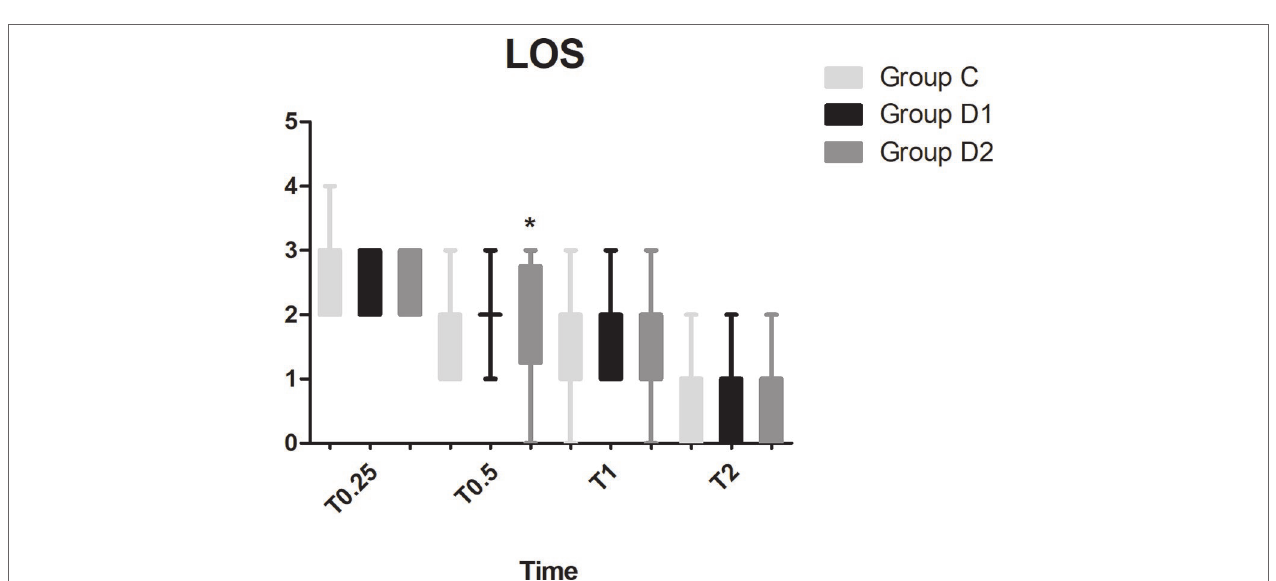
FIGURE 6 | Comparison of patient sedation among the three groups using the level of sedation (LOS). LOS: 1, the subject is anxious, agitated, or restless; 2, the subject is cooperative, oriented, tranquil, and responds to commands; 3, the subject is asleep but has a brisk response to light glabellar tap or a loud auditory stimulus; 4, the subject is asleep, has a sluggish response to a light glabellar tap or loud auditory stimulus; 5, the subject is asleep and unresponsive. * P < 0.05 vs. group